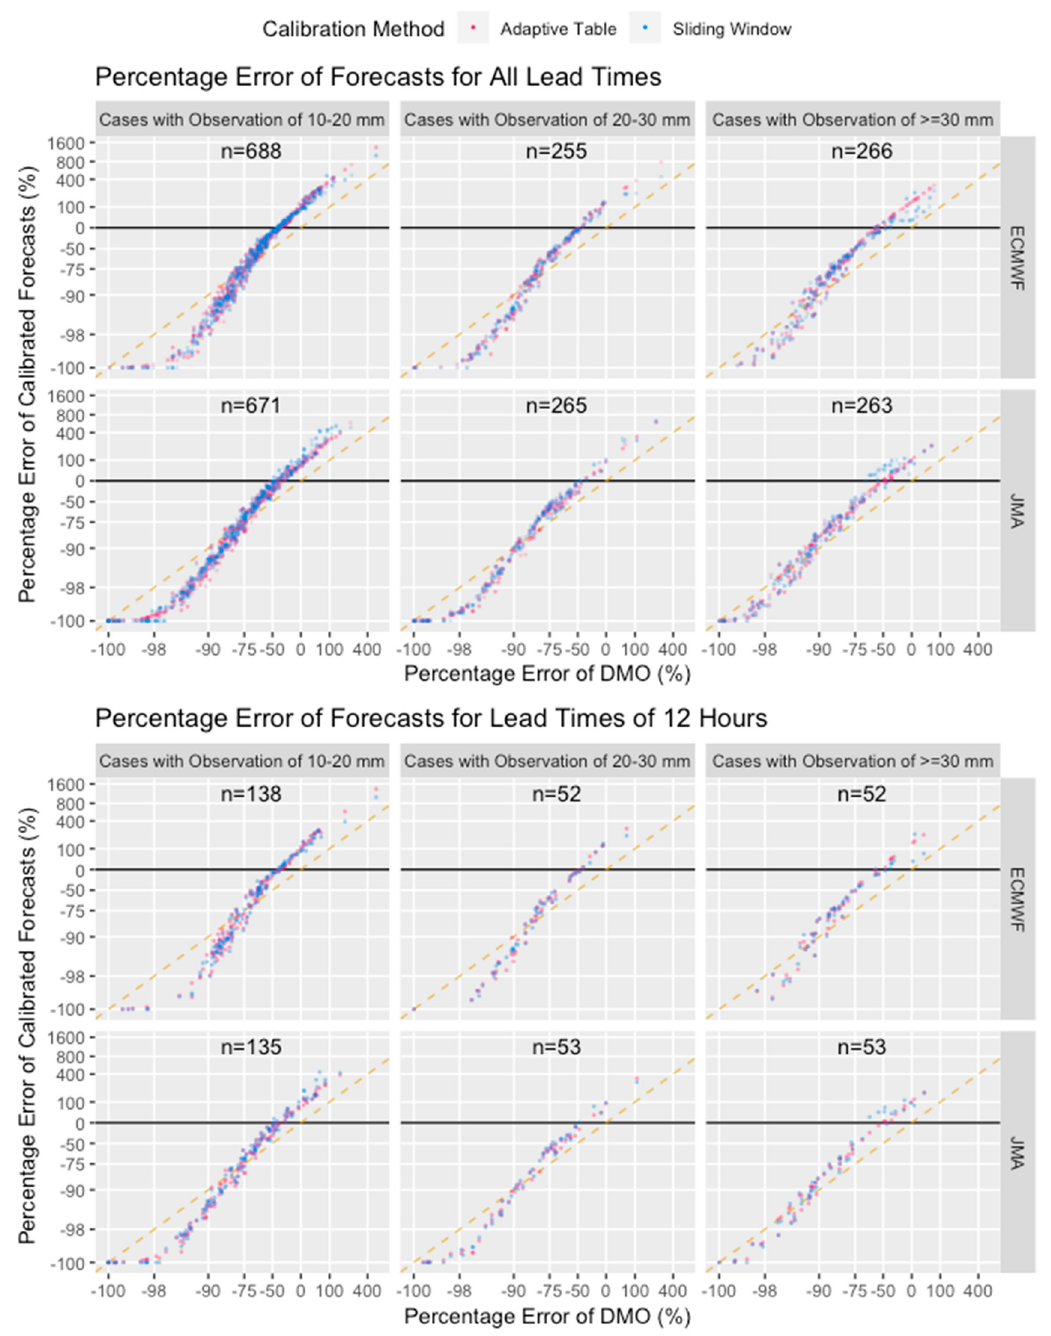
Figure 8. A scatterplot of the percentage error of forecasts calibrated with ( red ) Adaptive Table, and ( blue ) Sliding Window method, at ( the upper 6 panels ) all lead times, and ( the lower 6 panels ) specifically lead time of +12 h, against that of their corresponding DMO forecasts. The orange lines are y = x , as a reference of no calibrations to DMO forecasts. The number n at the top of each panel denotes the number of cases, the difference of which across models is due to data availability. The scales of both axes are logarithmic with a shift of − 101.